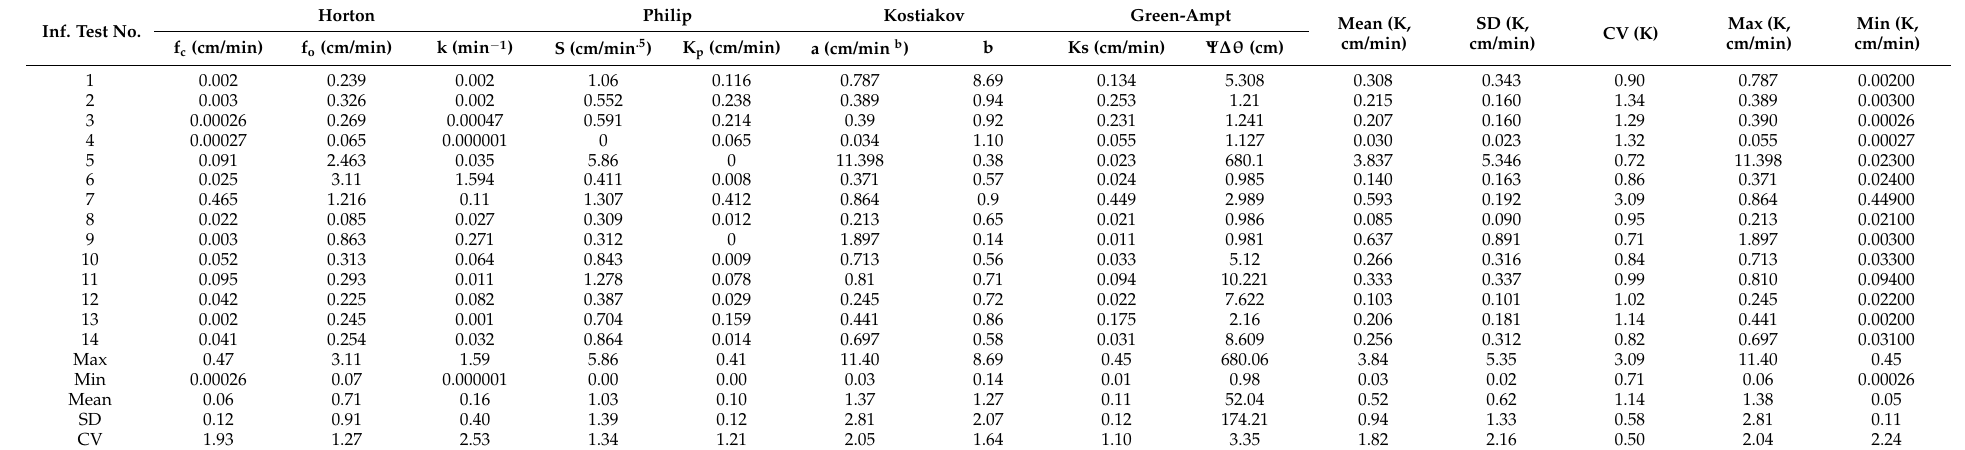
Table 1. Parameters of the infiltration models with summary